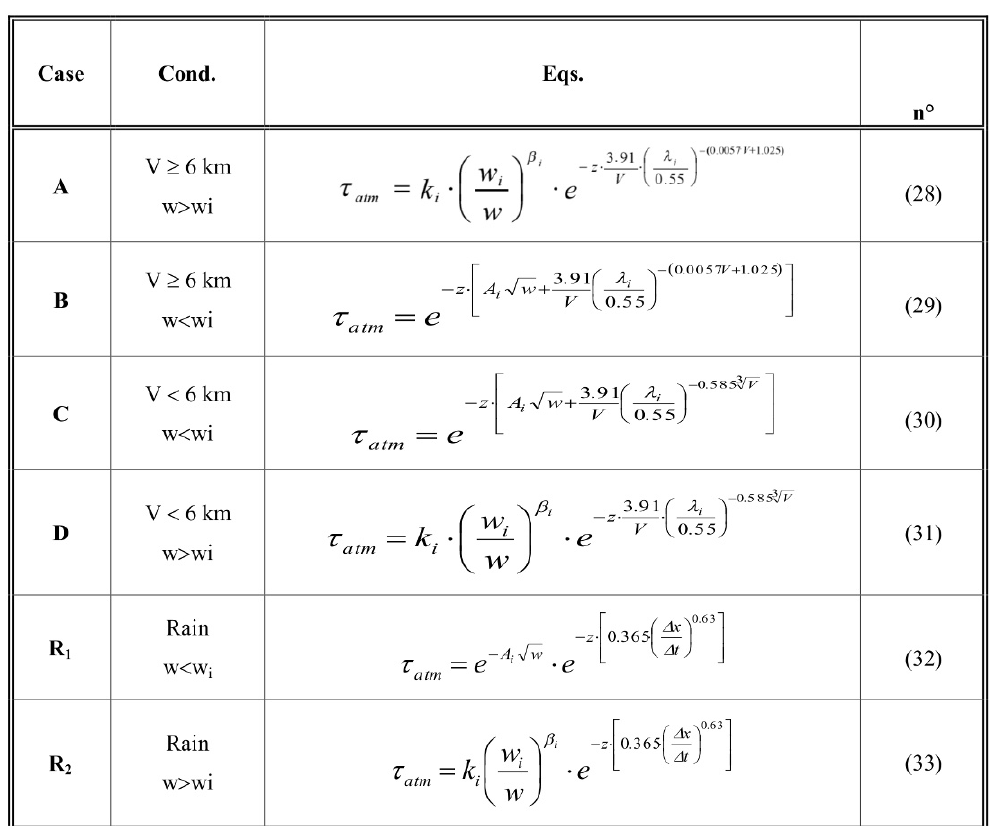
Table 7. One-way transmittance